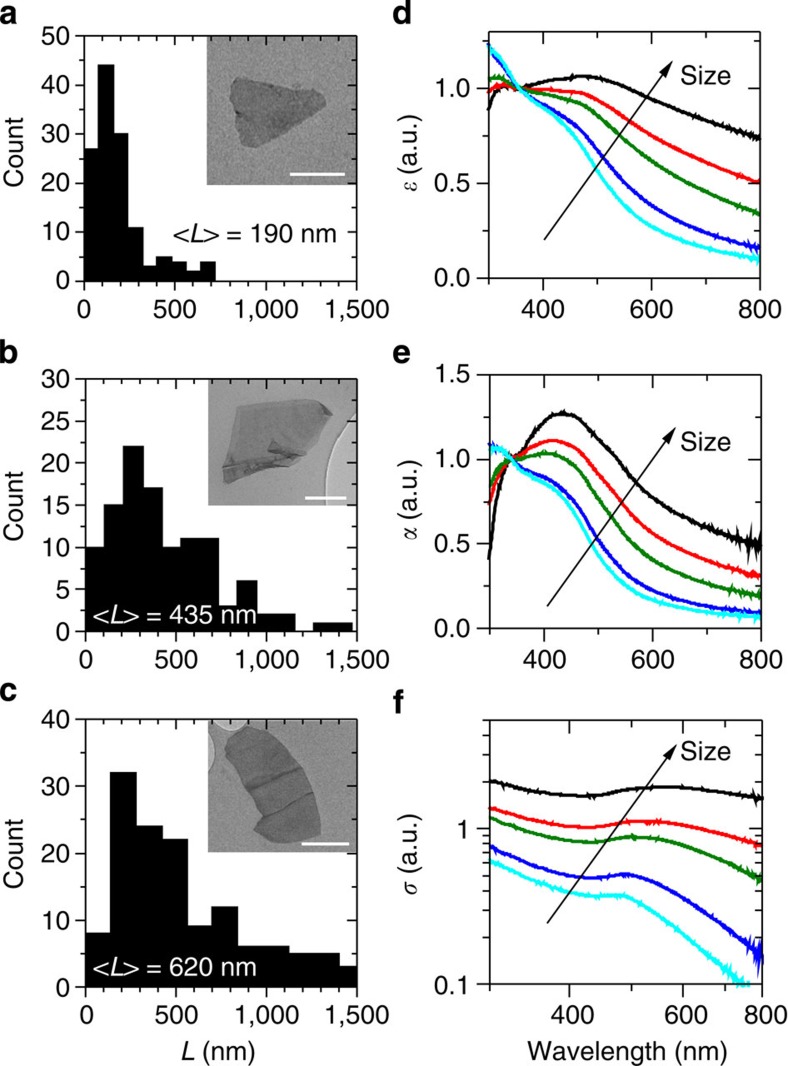
Size dependence of optical properties of exfoliated Black Phosphorous.(a–c) TEM length histograms of size-selected FL-BP in CHP including representative TEM images as insets (scale bars in a–c: 100, 200 and 200 nm). Sample sizes in a–c are 131, 111 and 140, respectively. (d) Extinction (ɛ) spectra normalized to 355 nm of FL-BP dispersions with different mean nanosheet lengths showing systematic changes as a function of size. Extinction spectra can be split into contributions from absorbance (α) and scattering (σ). (e) Absorbance spectra of the same dispersions (normalized to 340 nm) and (f) scattering spectra. Scattering spectra were obtained by subtracting the absorbance spectra from the normalized extinction spectra.